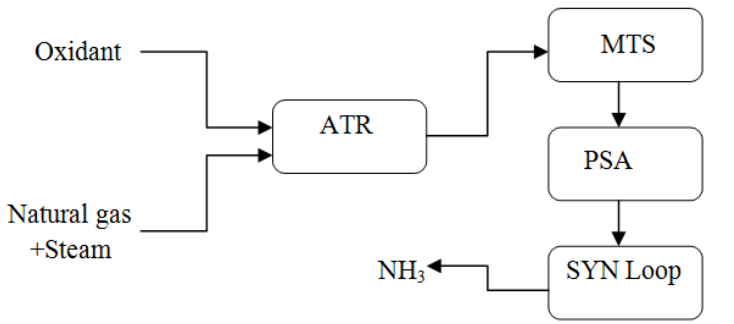
Figure 4. Ammonia process flowsheet for Casale A-600 concept, reproduced from the reference [21].